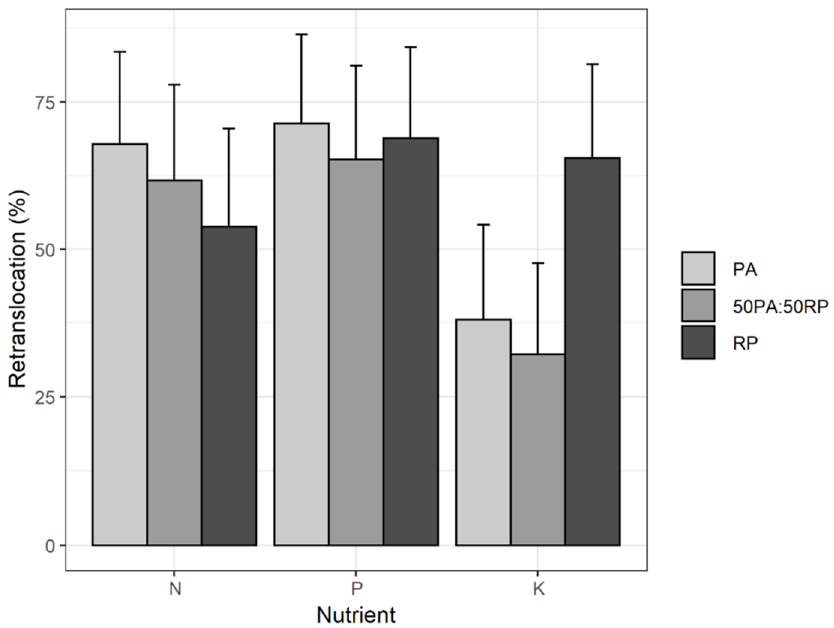
Figure 4. Average values and standard deviation of the percentage of e ffi cient retranslocation of nitrogen, phosphorus and potassium in P. alba (PA) and R. pseudoacacia (RP) monocultures and 50PA:50RP mixture.